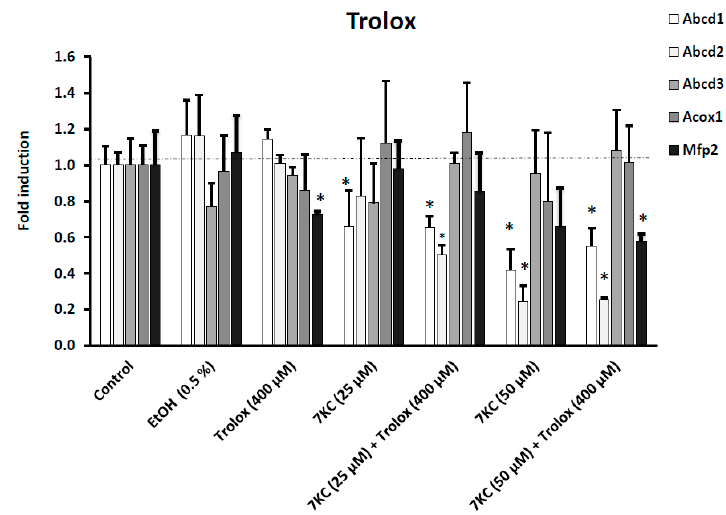
Figure 5. Effects of Trolox on 7-ketocholesterol-induced decreased transcription of Abcd1, Abcd2, Abcd3, Acox1 and Mfp2. Murine microglial BV-2 cells were cultured for 24 h in the presence of 7KC (25–50 µM) without and with Trolox (400 µM). The mRNAs of the peroxisomal transporters (Abcd1, and Abcd2), and of the peroxisomal enzymes (Acox1, and Mfp2) as well as of Abcd3 (a marker of the peroxisomal mass) were quantified by RT-qPCR. To this end, 36B4 was used as the reference gene. No difference was observed between control and vehicle (EtOH 0.1%–1%)-treated cells. The EtOH values correspond to the highest EtOH (0.5%) concentration added to the culture medium. Differences between control and 7KC-treated cells (* means significant differences by Mann–Whitney test; p ≤ 0.05). No differences between 7KC-treated cells and (7KC + (Trolox))-treated cells were observed. Data are mean ± SD of at least three independent experiments.